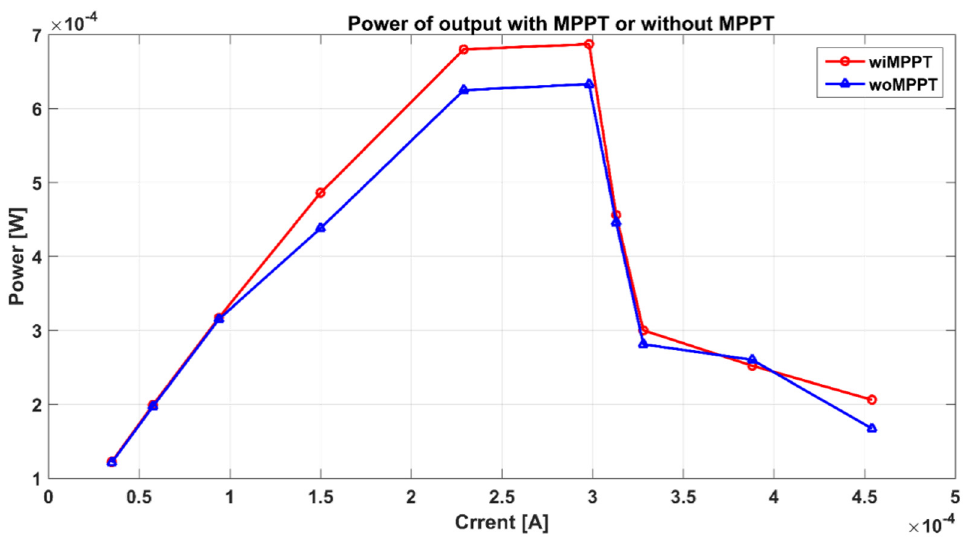
Figure 16. Power of output with MPPT and without MPPT.